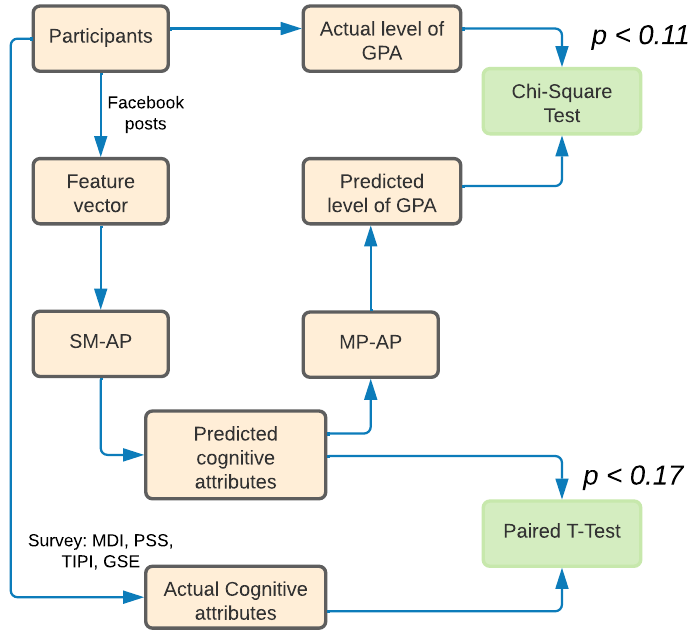
Figure 5. Design of the evaluation study to validate the model using real-life